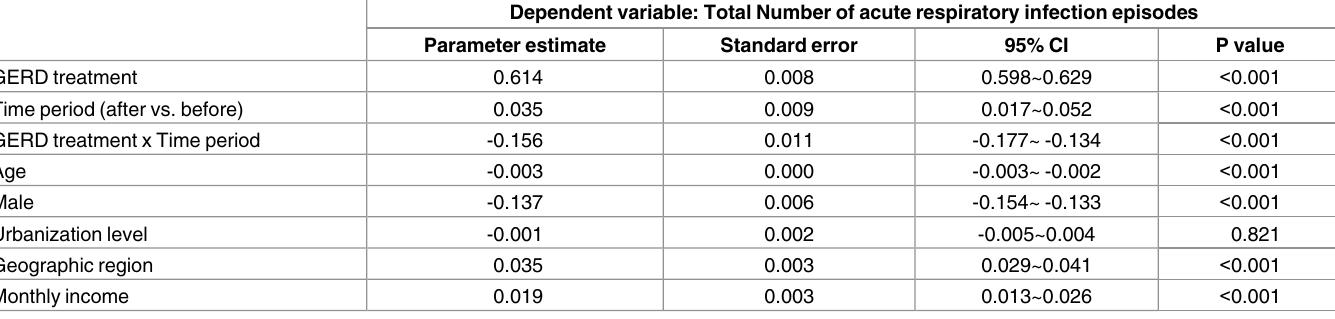
Table 3. Poisson regression analysis, difference-in-difference method: Impact of receiving treatment for gastroesophageal reflux disease (GERD) on the annual number of acute respiratory infection